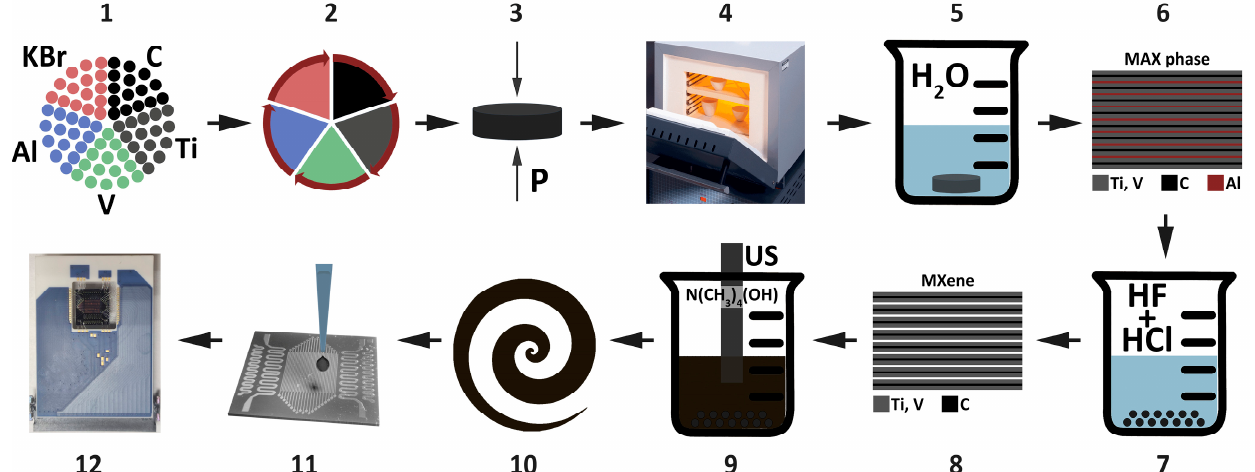
Figure 1. The technology route to form the chemiresistor/on-chip multisensor array from Ti 0.2 V 1.8 C MXene. The denotings are, 1—fabrication of Ti, V, Al, C, and KBr powders, 2—grinding of the powders, 3—molding of the intermediate products by pressing, 4—heat-treating the intermediate products, 5—water-washing of samples, 6—obtaining the Ti 0.2 V 1.8 AlC MAX phase, 7—a chemical etching of Al, 8—a preparing Ti 0.2 V 1.8 C MXene multilayer agglomerates, 9—a delamination of the agglomerates by ultrasonic treatment, 10—a separation/purification of layered MXenes via the centrifugation, 11—placing the MXene structures from inks over the multielectroded chip, and 12—the output chip wired into